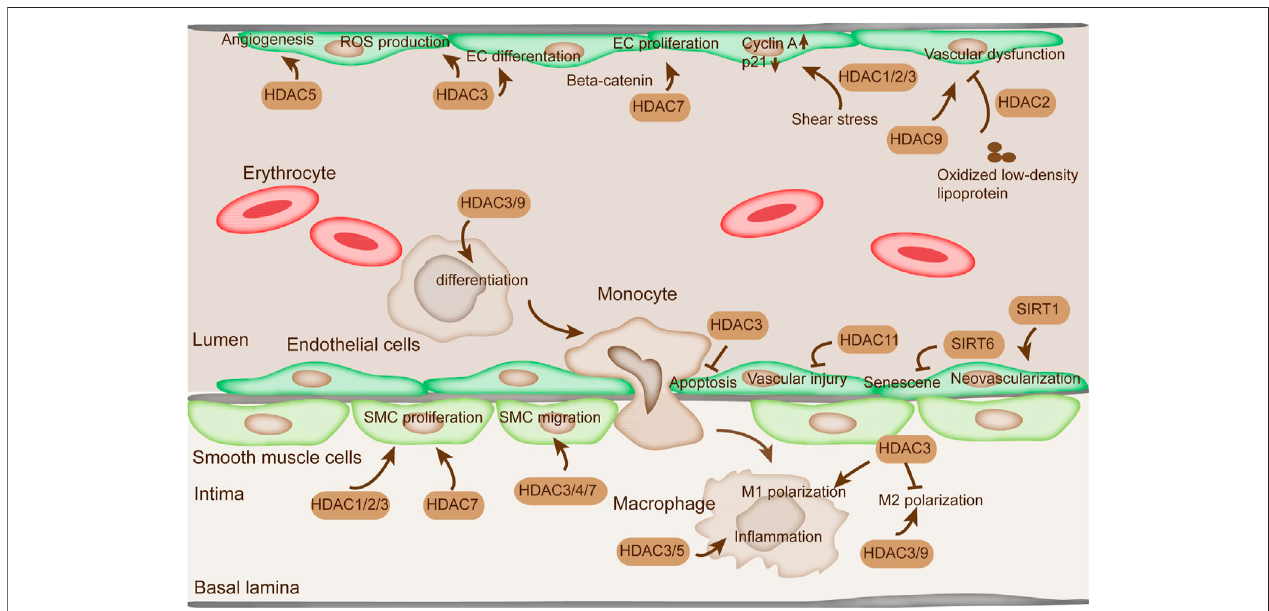
FIGURE 2 | The function of HDACs in ECs, SMC, and macrophages. The alteration of proliferation, migration, and apoptosis of ECs and SMCs is indispensable in AS. HDAC1/2/3/7 regulate SMC proliferation. HDAC3/4/7 are involved in SMC migration. HDAC3/5 modulate in fl ammation in macrophage. HDAC3/9 regulate proin fl ammatory geneexpression by modulating M2 macrophage polarization. HDAC11 plays acritical role in vascular injury. SIRT1 is directly related to EC senescence and apoptosis. SIRT6 protects EC from senescence. HDAC1/2/3 are reportedly involved in EC proliferation mediated by oscillatory shear stress. In addition, HDAC5 represses angiogenesis in